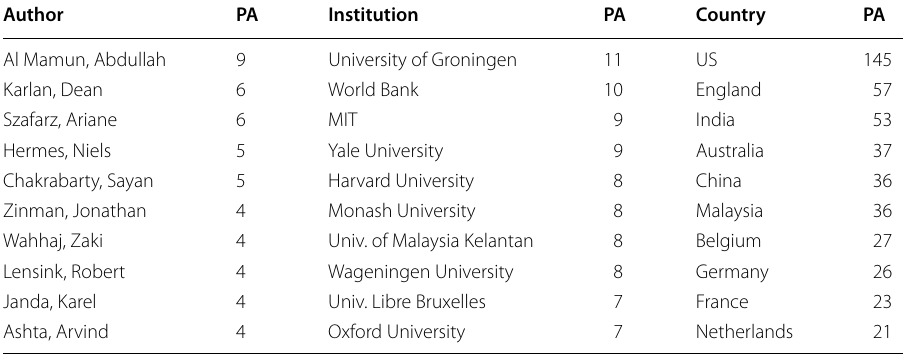
Table 4 Top authors, affiliated institutions and countries for sample statistics of 524 papers published on microfinance (demand side) between 1:2012 and